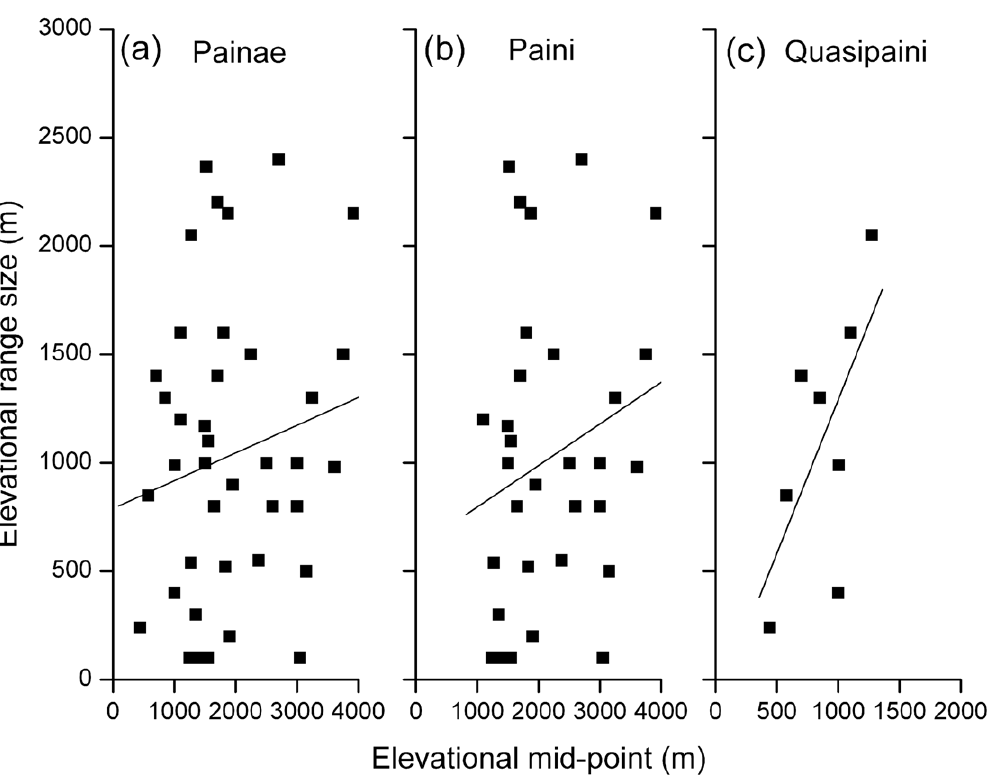
Figure 6. Relationship between altitudinal range midpoints and range size of spiny frogs. The relationship is shown for (a) the subfamily Painae, (b) the tribe Painiand and (c) the tribe Quasipaini respectively. The fitted line represents an ordinary least square (OLS) linear regression.